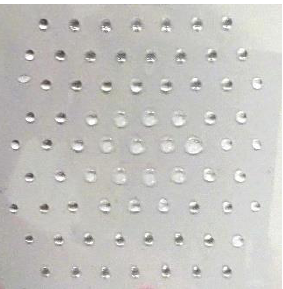
Figure 3. A photo of a grid of water droplets deposited on the polymer surface. In the center, where surface wettability was higher, we can observe wider droplets. The size of the image is 5 × 5 cm 2 .